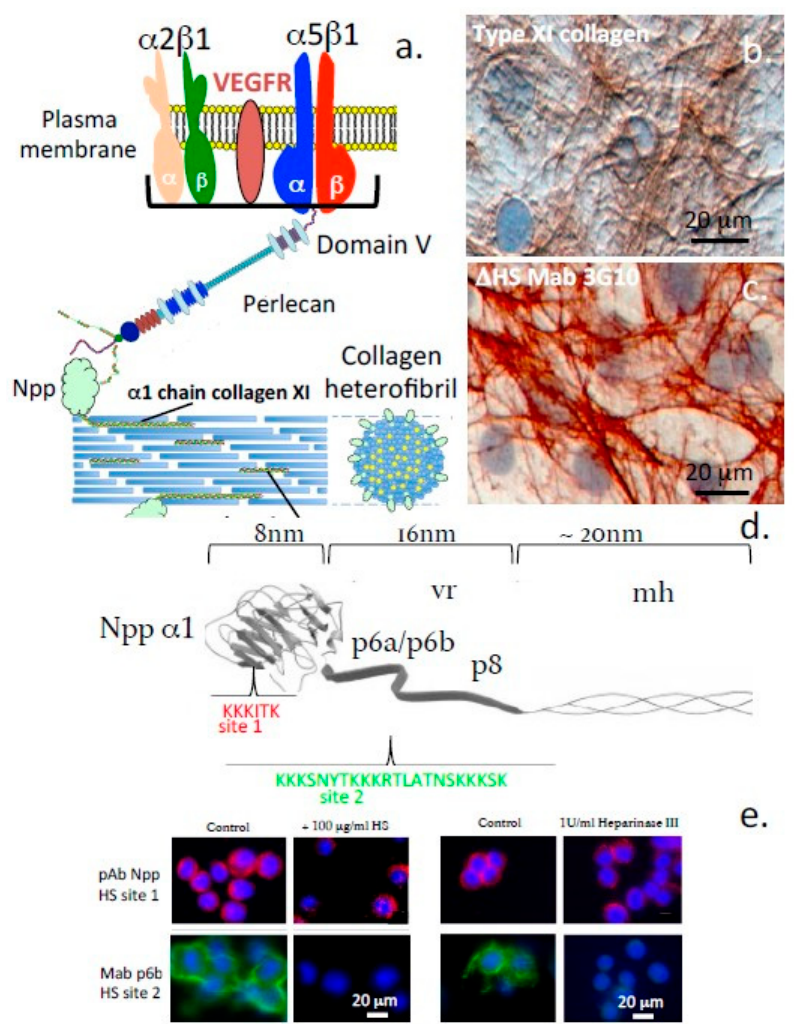
Figure 5. Perlecan interacts with cell surface integrins and type XI collagen in the PCM. ( a ) Diagrammatic schematic representation of the interaction of perlecan with cell surface integrins and the HSbinding sites of type XI collagen at the ovine disc cell surface. ( b , c ) Immunoperoxidase localisation of type XI collagen ( b ) and perlecan HS ( c ) in monolayer cultures of annulus fibrosus cells. ( d ) Schematic of the HS binding sites on the exposed Npp α 1 domain of a type XI collagen heterofibril ( e ) Immunofluorescence localisation of type XI collagen in cultured chondrosarcoma cells showing pericellular HS-PGs. Segments a-c reproduced from [63]. Segments d and e reproduced from [64]. All plates in ( e ) are provided at the same magnification, 20 µm scale bar applicable to all segments.